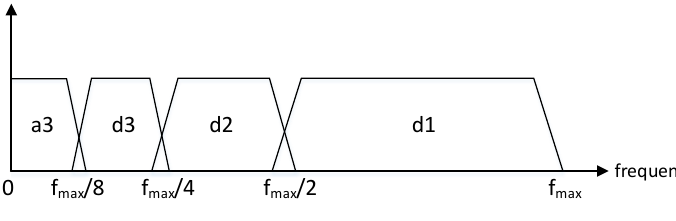
Figure 4. Discrete wavelet transform frequency ranges of the different